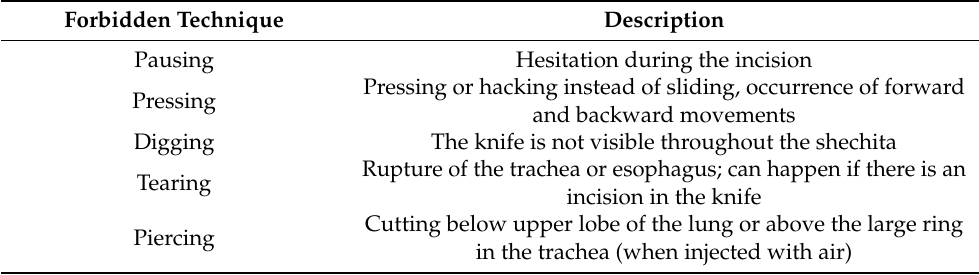
Table 2. Five Forbidden Techniques to be Avoided in Kosher Slaughter. Forbidden Technique Description Pausing Hesitation during the incision Pressing or hacking instead of sliding, occurrence of forward Pressing and backward movements Digging The knife is not visible throughout the shechita Rupture of the trachea or esophagus; can happen if there is an Tearing incision in the knife Cutting below upper lobe of the lung or above the large ring Piercing in the trachea (when injected with